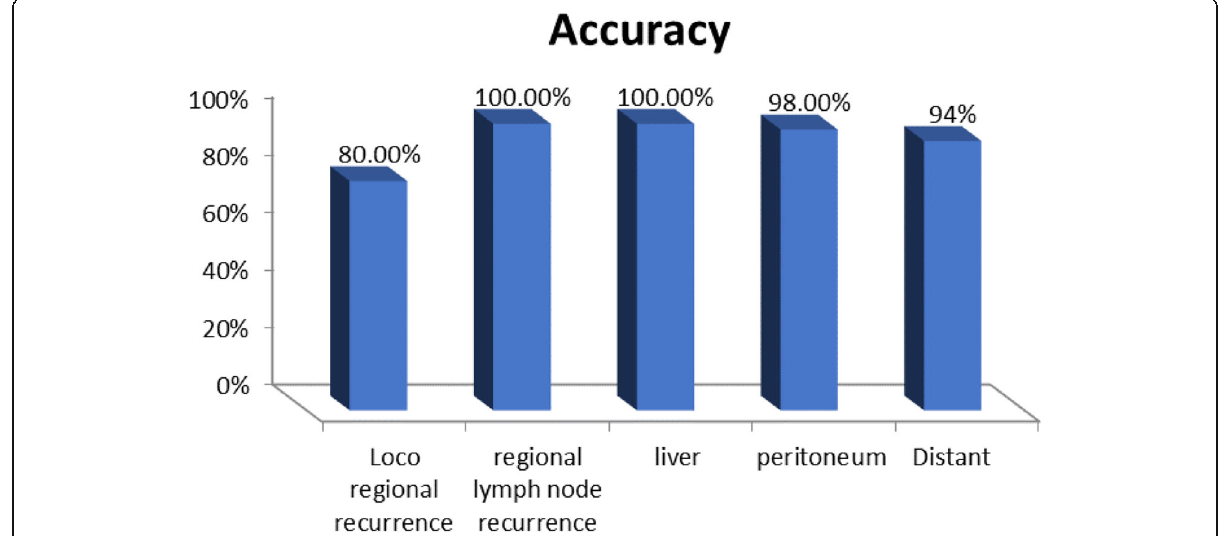
Fig. 1 Graph summarizes the accuracy rates of PET/CT estimated on organ-based